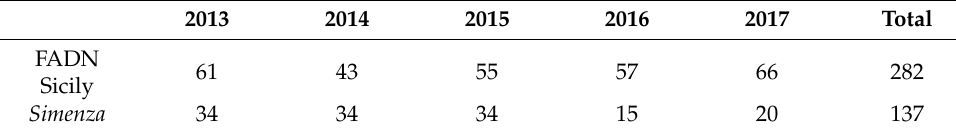
Figure 1. Map of Simenza members (2020). Table 2. Number of observations per year.